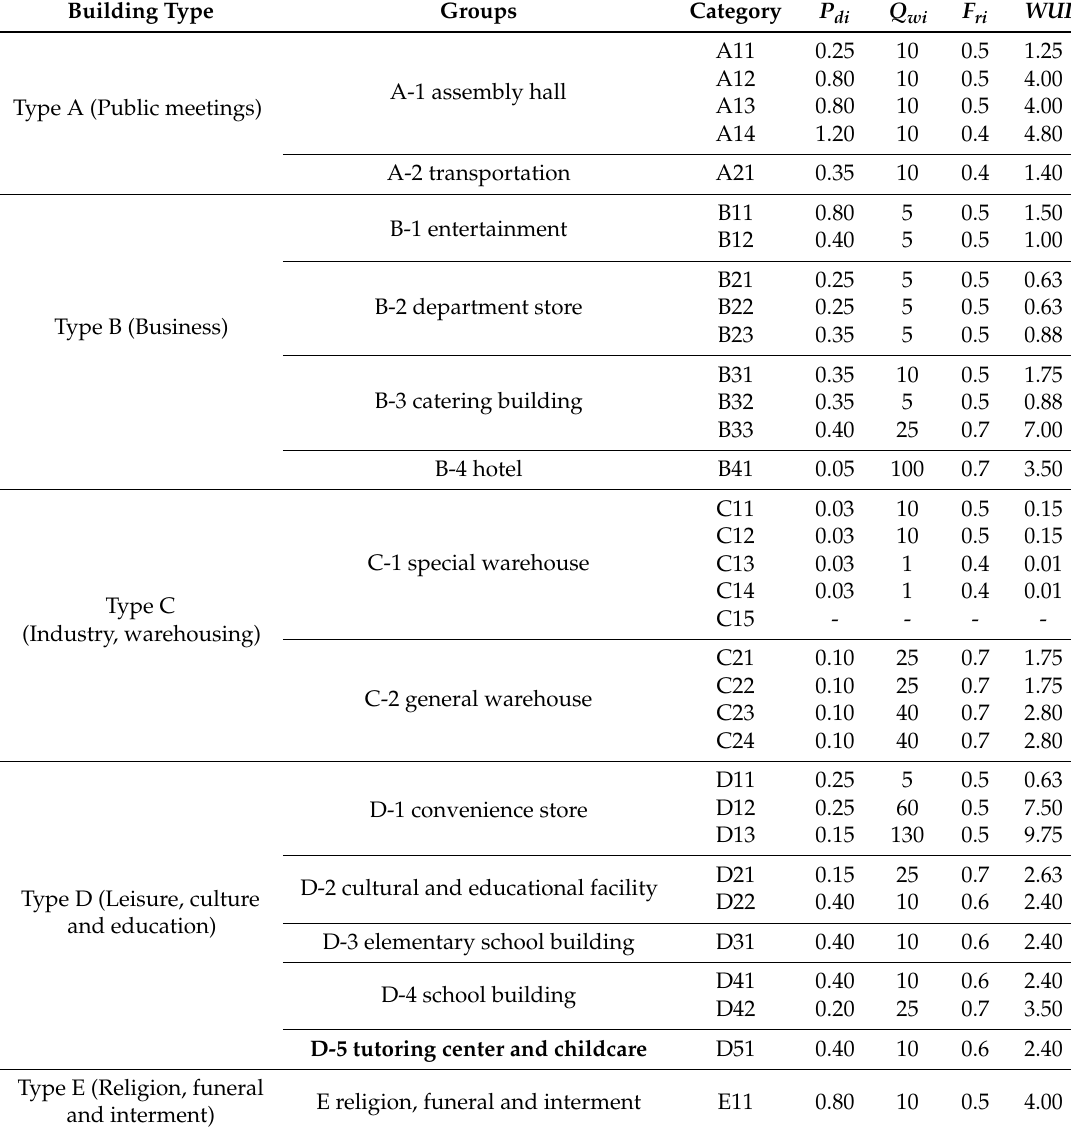
Table 2. WUI for space categorizations of the 52 types of baseline water